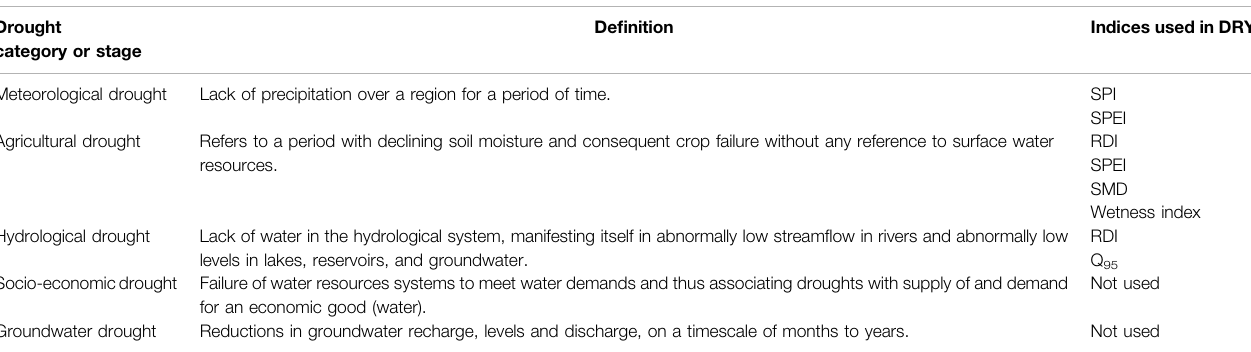
Drought category or